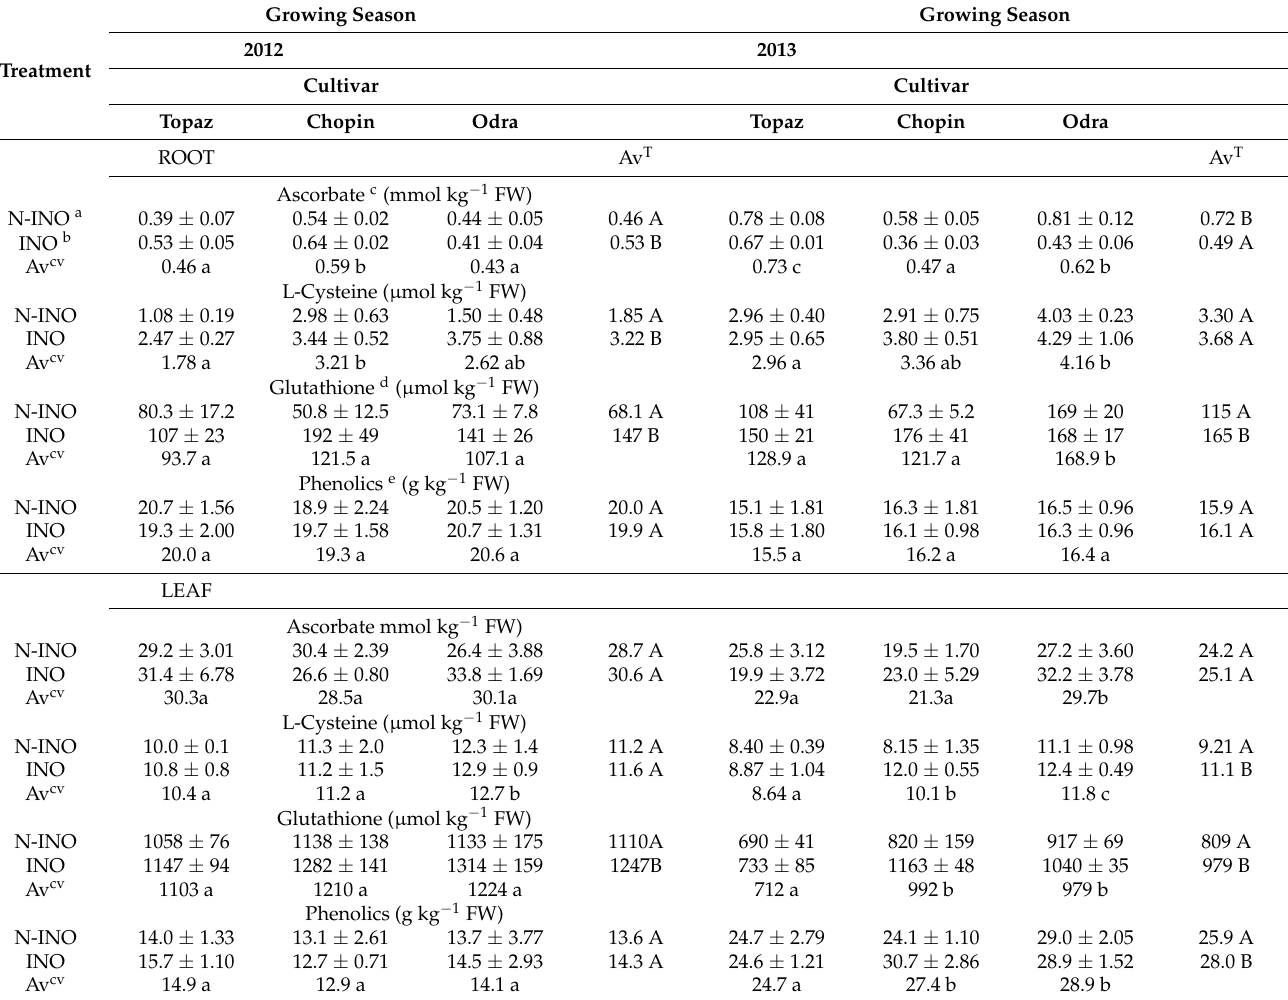
Table 3. Root, leaf, and fruit non-enzymatic antioxidant content: year, cultivar, and bacterial–fungal inoculation effects.